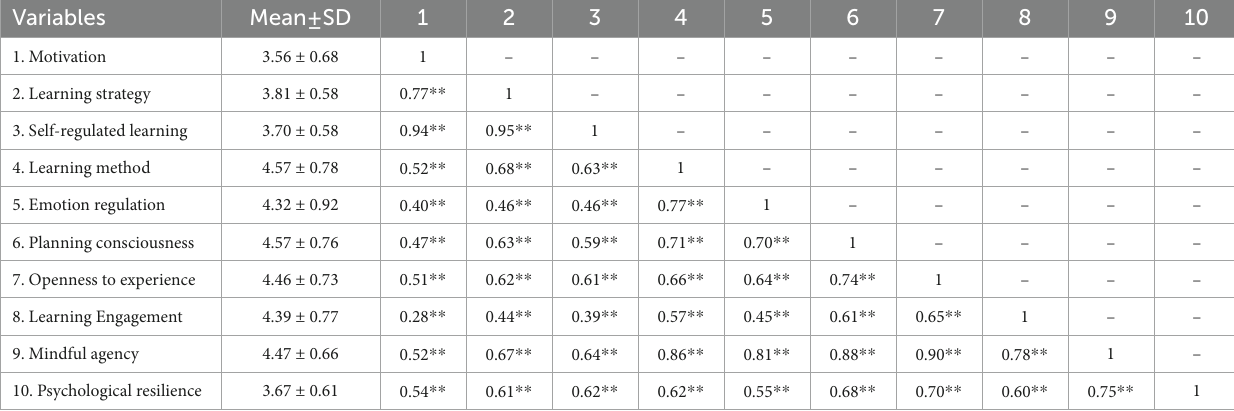
TABLE 2 Means, standard deviations, and correlations among the study variables ( N = 196). Variables